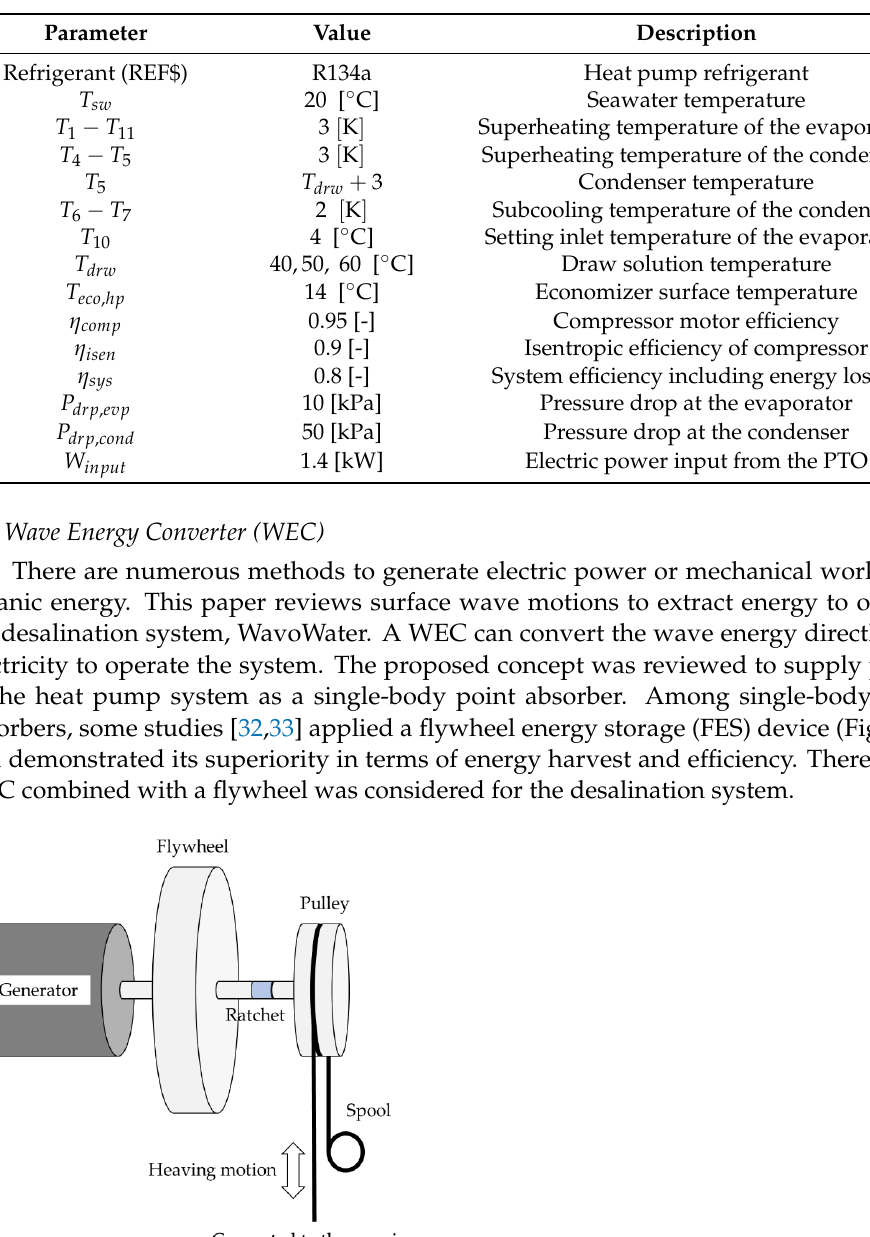
Table 2. Input values for the heat pump system.